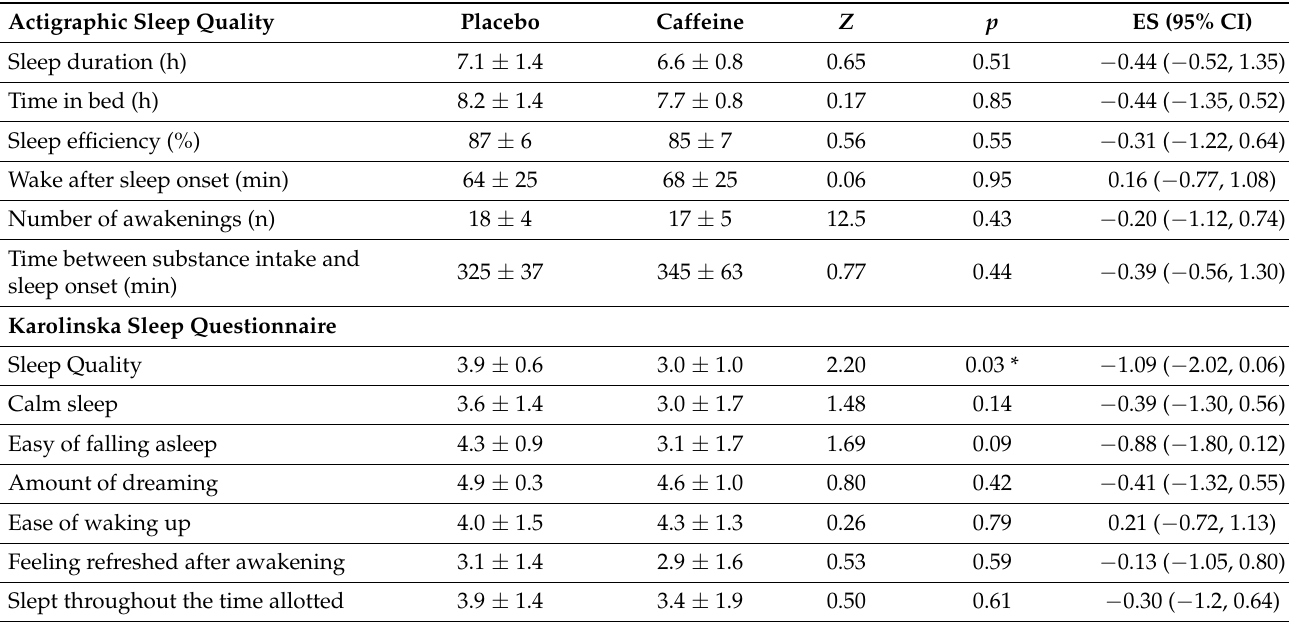
Table 2. Sleep quality measures for caffeine and placebo